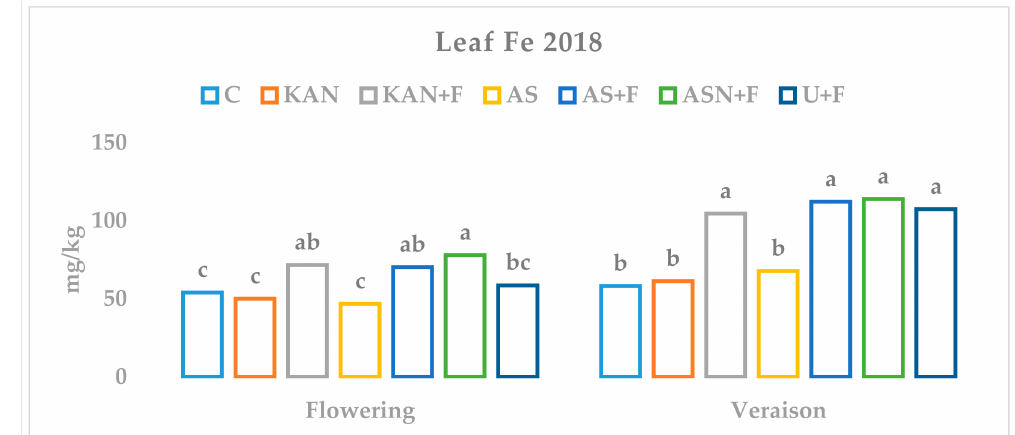
Figure 2. Influence of soil nitrogen fertilization and foliar fertilization on Fe grapevine leaves dynamic in 2018. Values marked with different letters refer to statistically significant differences ( p < 0.05) depending on treatment.